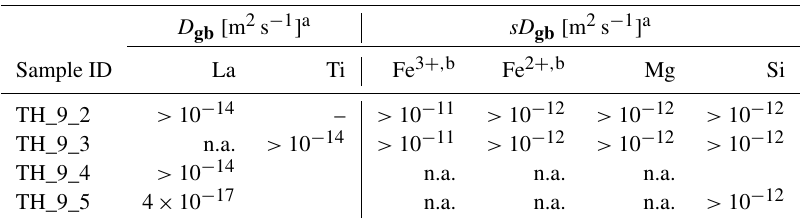
Figure 7. Diffusion profiles perpendicular to grain boundary of sample TH_9_2 (1005). Panels (a) , (c) , and (e) are extracted from quantified 2D STEM EDS elemental maps (b) measured at a distance of 500 and 2000nm from the diffusion source (profile 1, profile 2). The con- centrations in each profile are integrated over 40nm in the x direction, parallel to the grain boundary. The counting error is smaller than the symbols in the profiles. (a) La profiles, (b) STEM element distribution map indicating the location of the extracted profiles, (c) Mg profiles, (d) Fe profiles. Table 3. Grain boundary diffusion rates of multiple elements in YAG. The abbreviation n.a. means not assigned because the concentration is below the detection